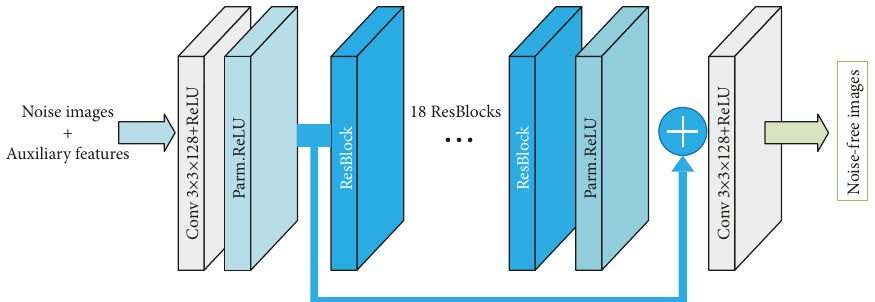
Figure 4: Design of a deep neural network model for an access residual